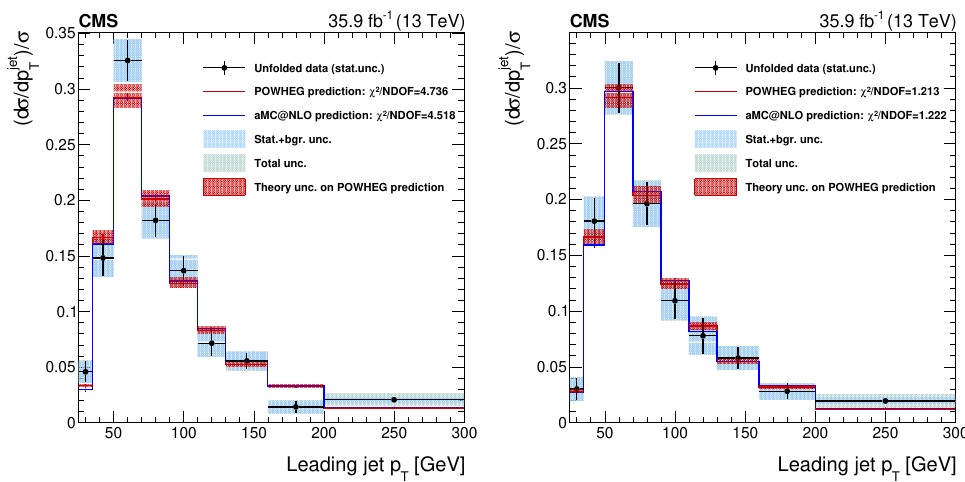
Figure 11 . Di(cid:11)erential distributions for W + (left) and W (cid:0) (right), in the full SR. The leading jet transverse momentum is unfolded at the dressed leptons level, as described in the text. The red band around the powheg prediction represents the theory uncertainty in it. The e(cid:11)ect on the unfolded data of this uncertainty, through the unfolding matrix, is included in the shaded bands described in the legend.